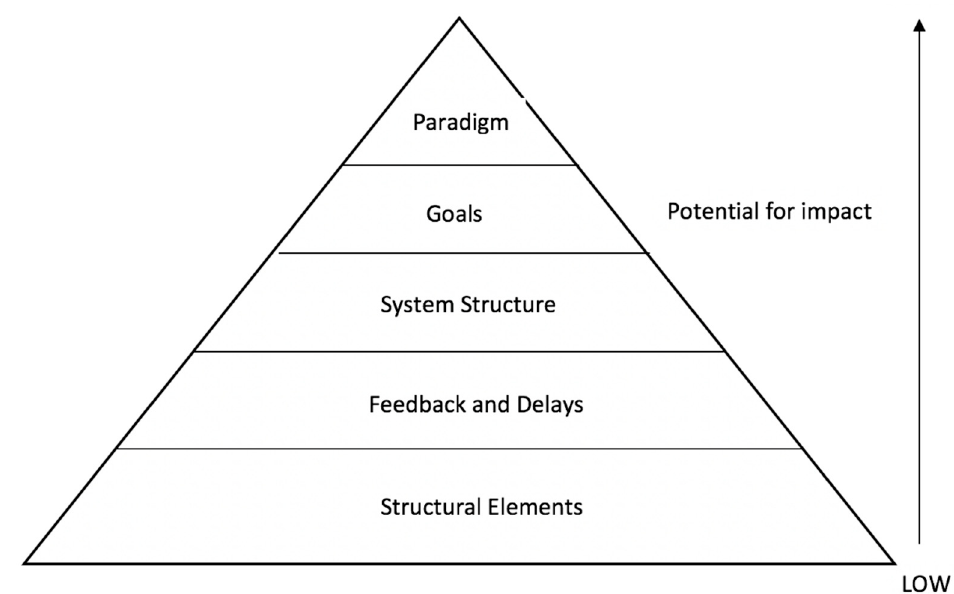
Figure 1. Intervention Level Framework (Johnston et al., 2014).